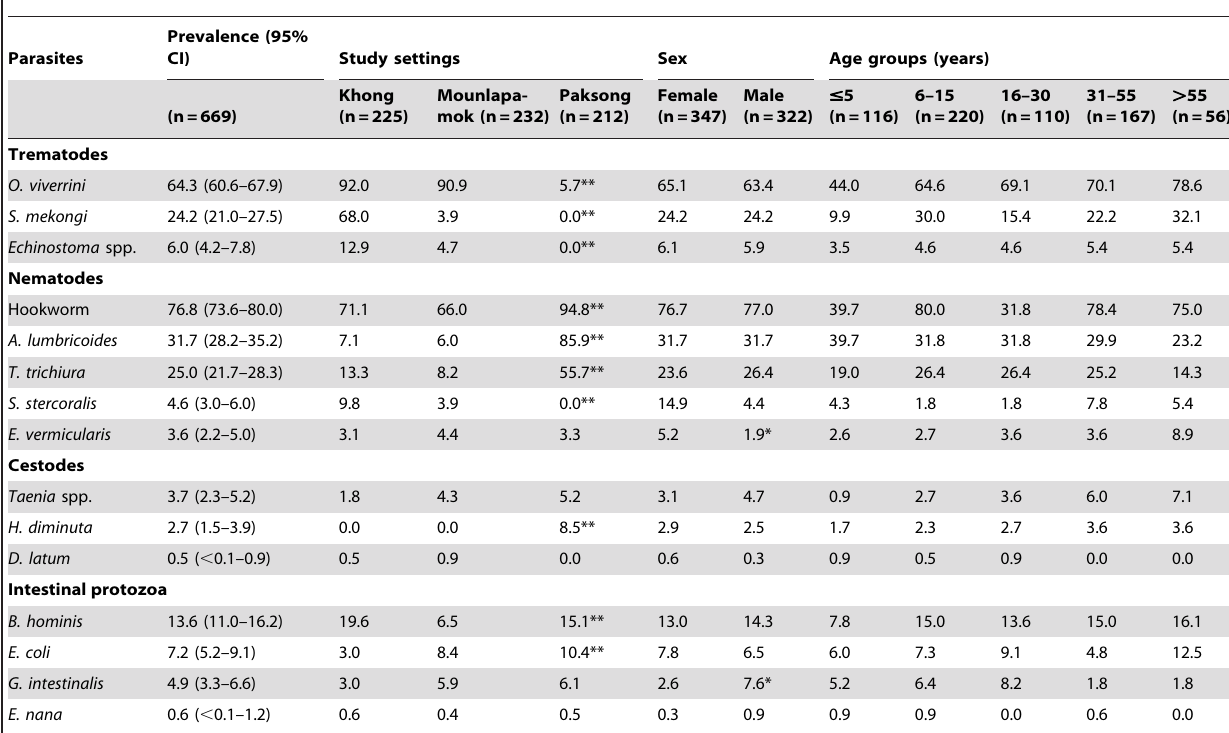
Table 1. Prevalence of intestinal parasitic infections diagnosed by Kato-Katz plus formalin-ethyl-acetate concentration (n=669).